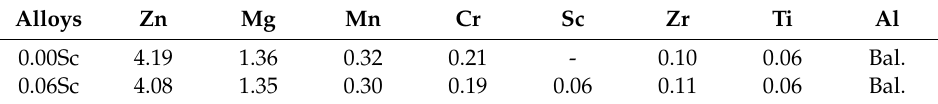
Table 1. Chemical compositions of the experimental alloys (wt